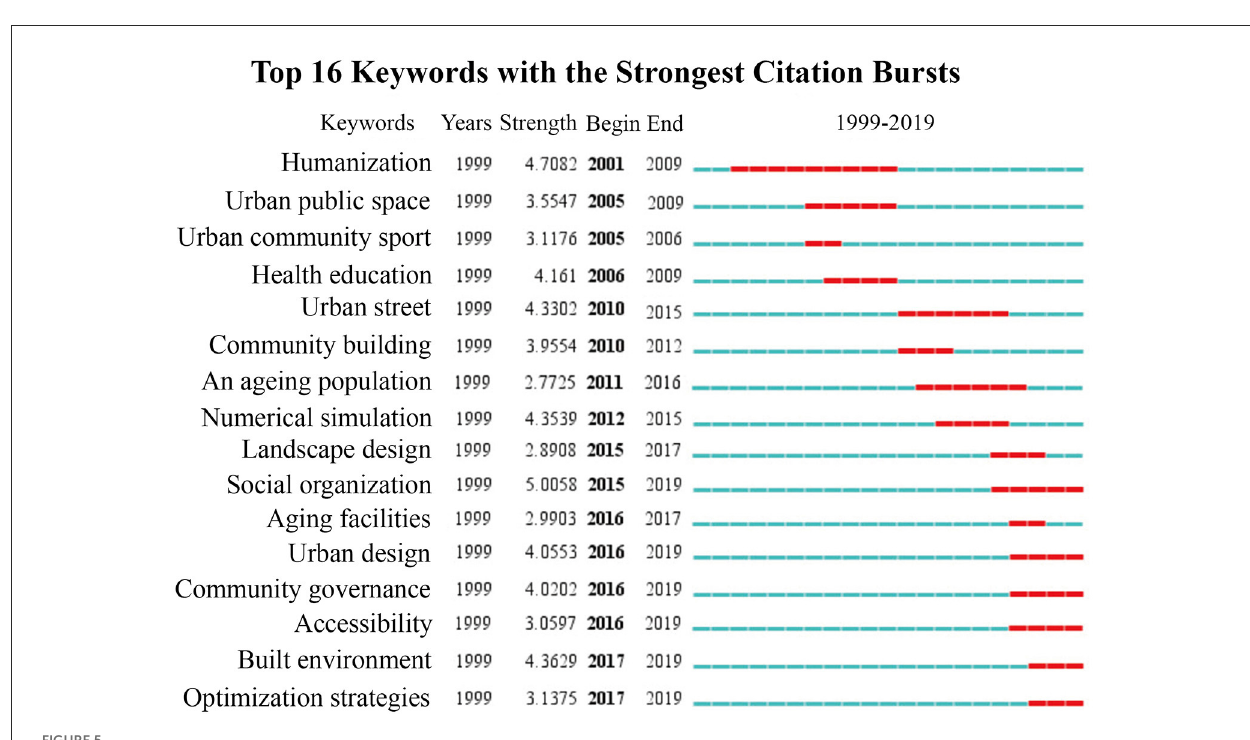
FIGURE5 List of emergent words for research themes